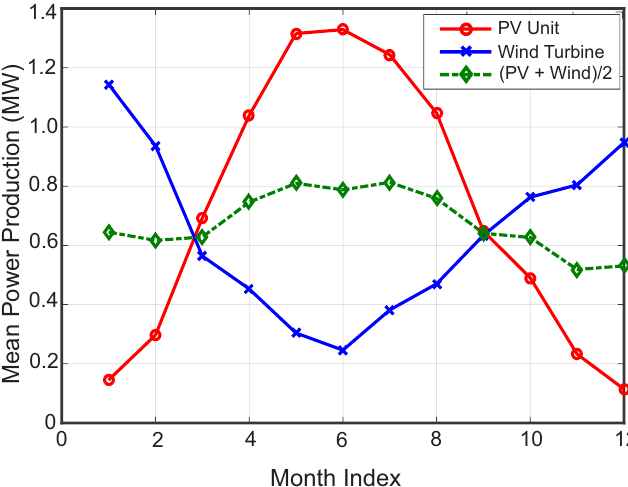
Figure 2. Temporal Complementarity: Variations in mean monthly power production at a given location. Spatial complementarity at a given geographical location is evaluated by time averaging the correlation coefficient between solar and wind capacity factors [31]. More negative values mean higher solar-wind complementarity. Spatial complementarity across different regions of Ireland is shown in Figure 3. The areas inside darker toned blocks have higher solar-wind complementarity as compared to the regions inside lighter toned blocks. The sites labeled as A, B, C and D were chosen for the solar-wind complementarity analysis in this study. More details on finding the complementarity